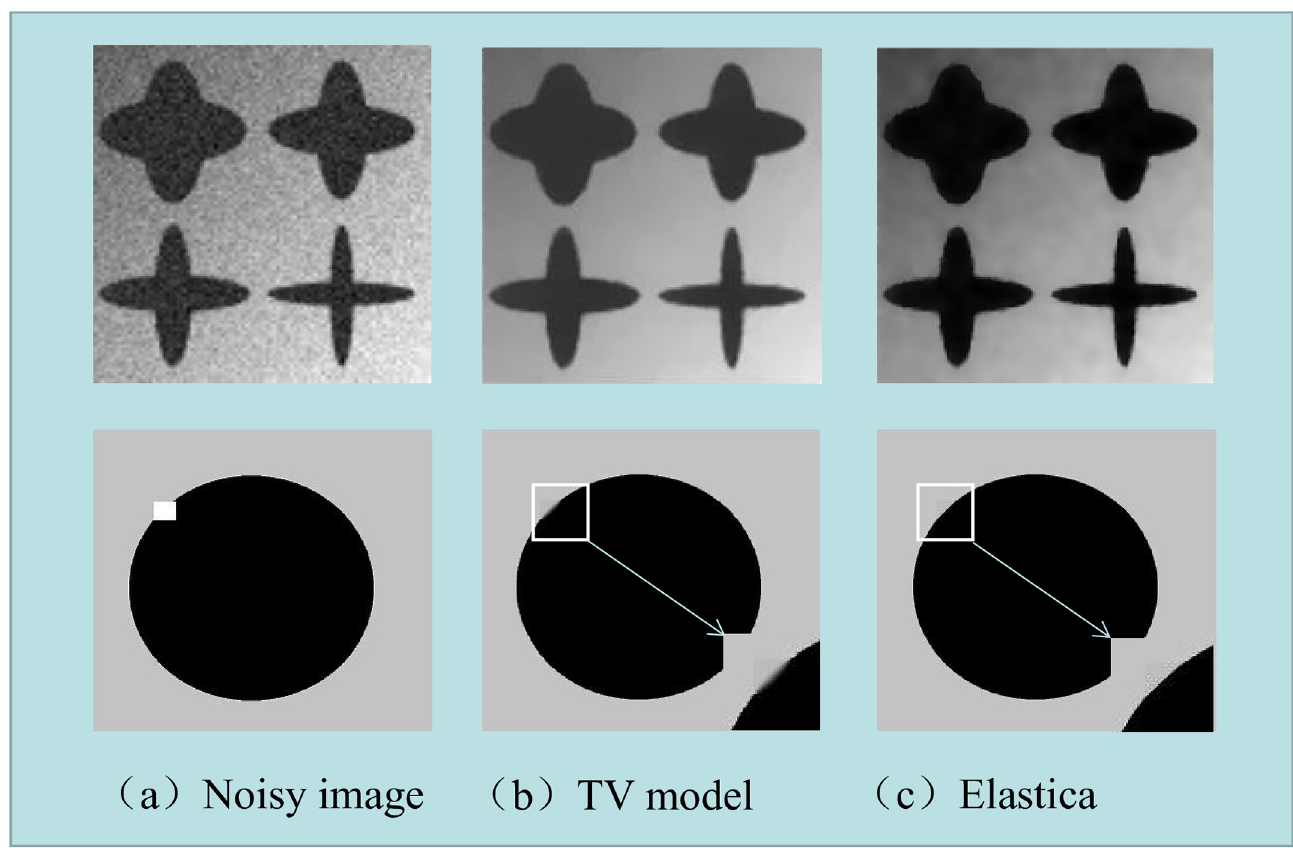
Fig 4. Image denoising and inpainting results by TV model and Euler’s elastica method.